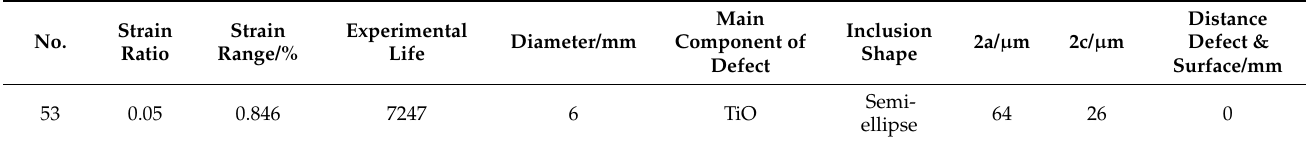
Table 8. Experimental data of specimen No. 53.